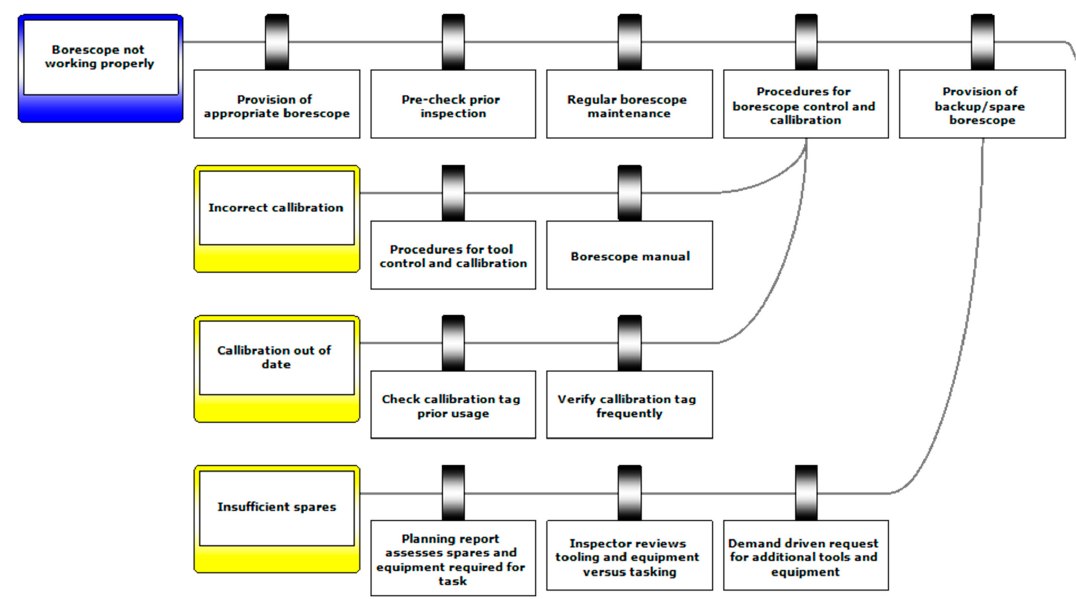
Figure A2c. “Borescope not working properly” threat path.